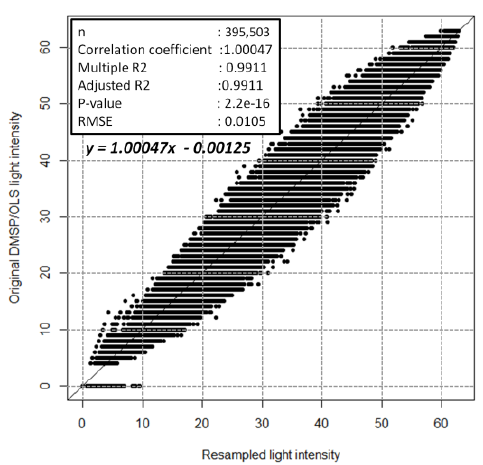
Figure 9. comparison result of annual total number of Event visitor with resampled light intensity all over Japan